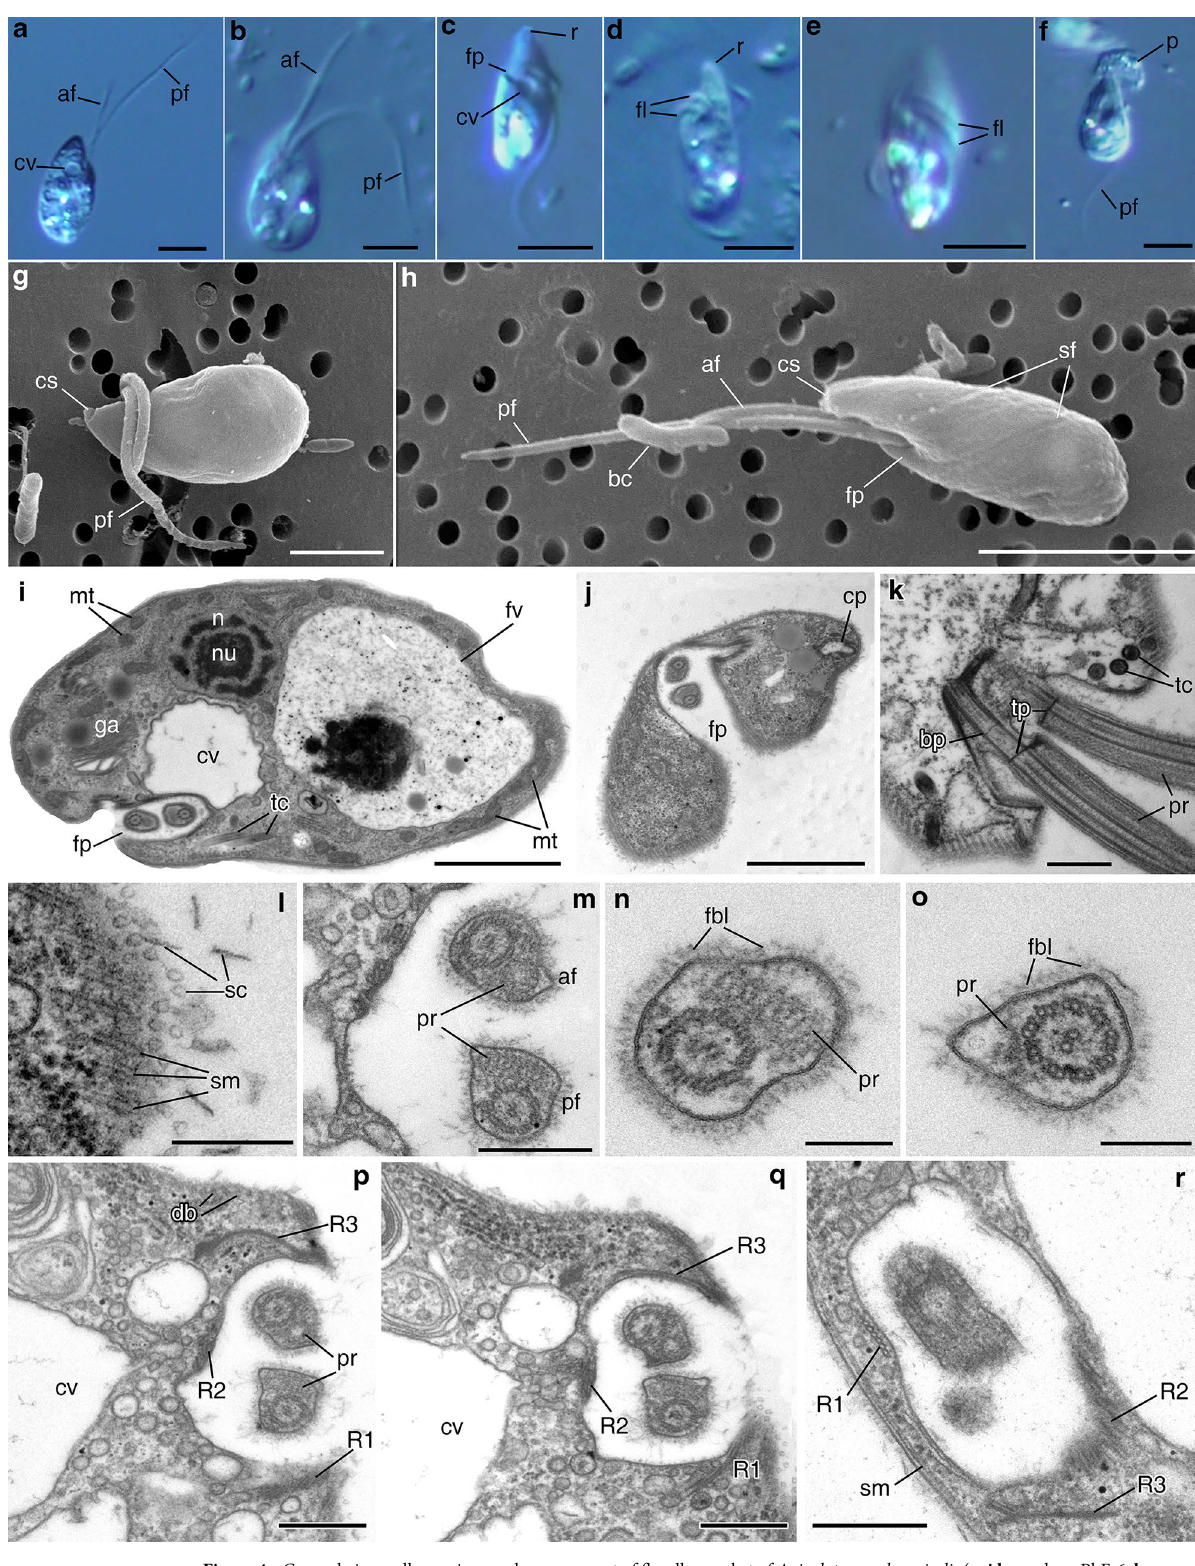
Figure 4. General view, cell coverings and arrangement of flagellar pocket of Apiculatamorpha spiralis ( a – j , l – r —clone PhF-6, k — clone PhF-5). (a–f) living cell, LM, DIC; (g,h) general cell view, SEM; (i) longitudinal section of the cell, (j) transverse section of the anterior cell end; (k) arising of the flagella from flagellar pocket; (l) scales on the cell surface; (m–o) cross sections of the flagella ( n — posterior flagellum, o —anterior flagellum); (p–r) microtubular roots and flagellar pocket. af anterior flagellum, bc bacterium, bp basal plate, cp cytopharynx, cs cytostome, cv contractile vacuole, db dorsal band of the microtubules, fbl fiber layer, fl flagella, fp flagellar pocket, fv food vacuole, mt mitochondrion, n nucleus, nu nucleolus, pf posterior flagellum, p prey, pr paraflagellar rod, r rostrum, R1 microtubular root R1, R2 microtubular root R2, R3 microtubular root R3, sf spiral furrow, sc scales, sm subpellicular microtubules, tc trichocyst, tp transversal plate. Scales: ( a – f ) 5, ( g ) 2, ( h ) 5, ( i , j ) 2, ( k ) 0.5, ( l ) 0.2, ( m ) 0.5, ( n , o ) 0.2, ( p – r ) 0.5